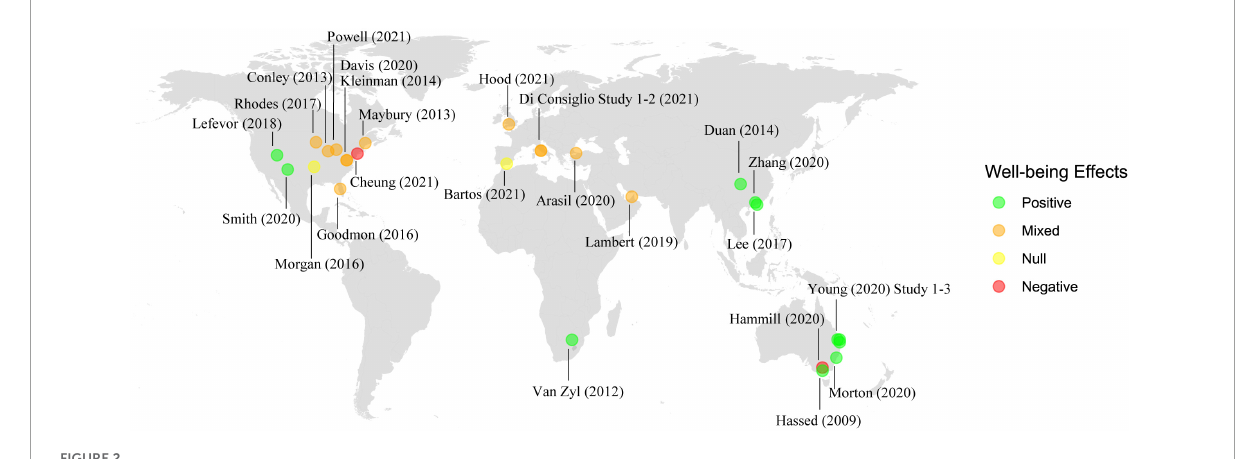
FIGURE2 Summary of study effects on psychological well-being by geographic